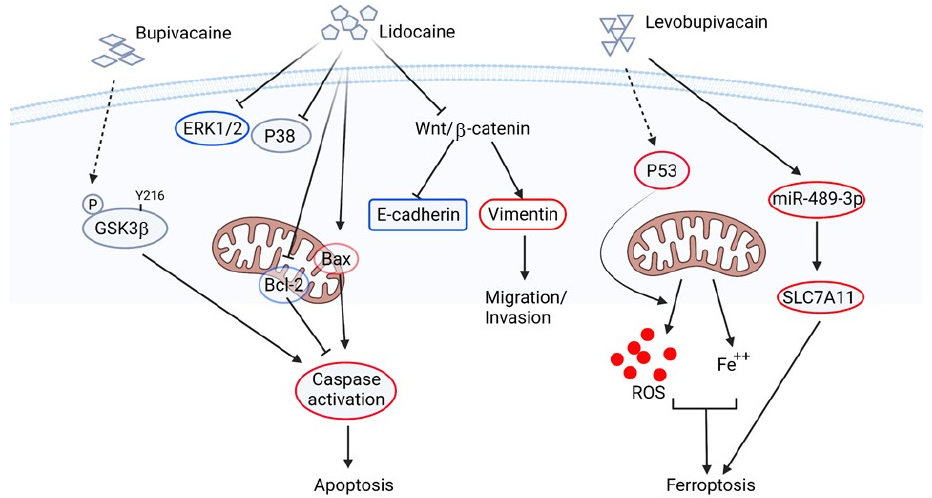
Figure 2. Schematic illustration of anti-cancer signaling pathways of lidocaine and its derivatives in cancer cells. The dotted line represents the pathway is proven, but the mechanism is unknown. The figure is made by an online tool at BioRender.com (accessed on 14 June 2022) Additionally, immunosuppression is one of the hallmarks of cancer, where the innate immunity of the host is usually suppressed during cancer progression. Therefore, activat- ing these immune responses has become one of the therapeutic strategies for killing cancer cells. Current strategies mainly focus on the induction of T cell cytotoxic activity in which the T cell-mediated cytotoxic to cancer cells, such as immune checkpoint therapy, has be- come a popular focus in killing cancer cells [78]. It is unknown whether these local anes- thetics can promote or synergize with these T-cell-mediated immunotherapies. However,